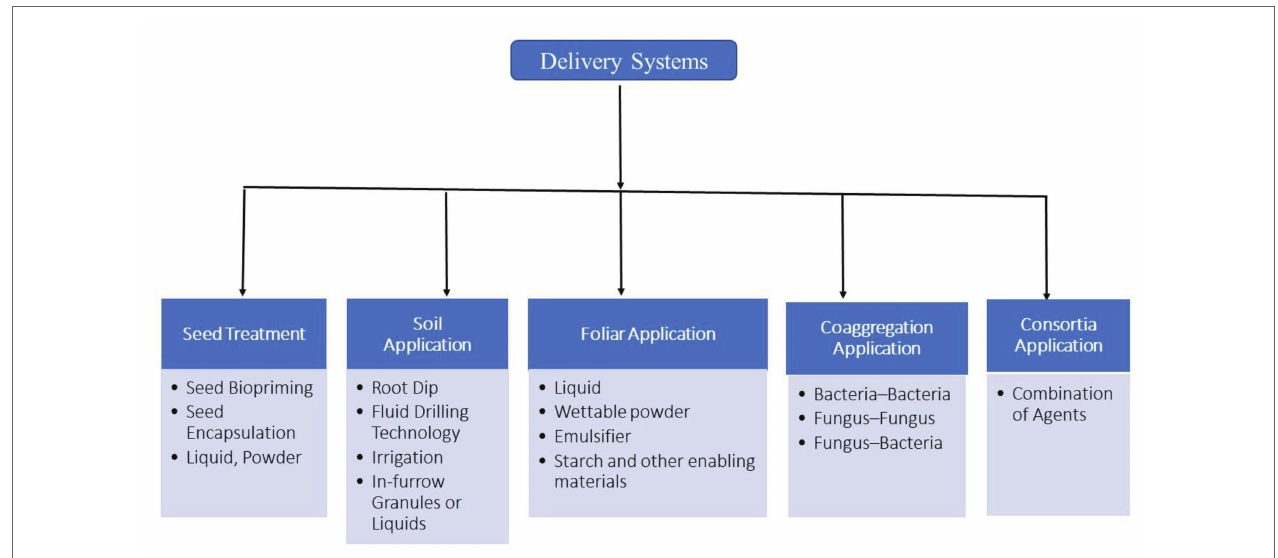
FIGURE 3 | A diagram of different delivery systems employed in